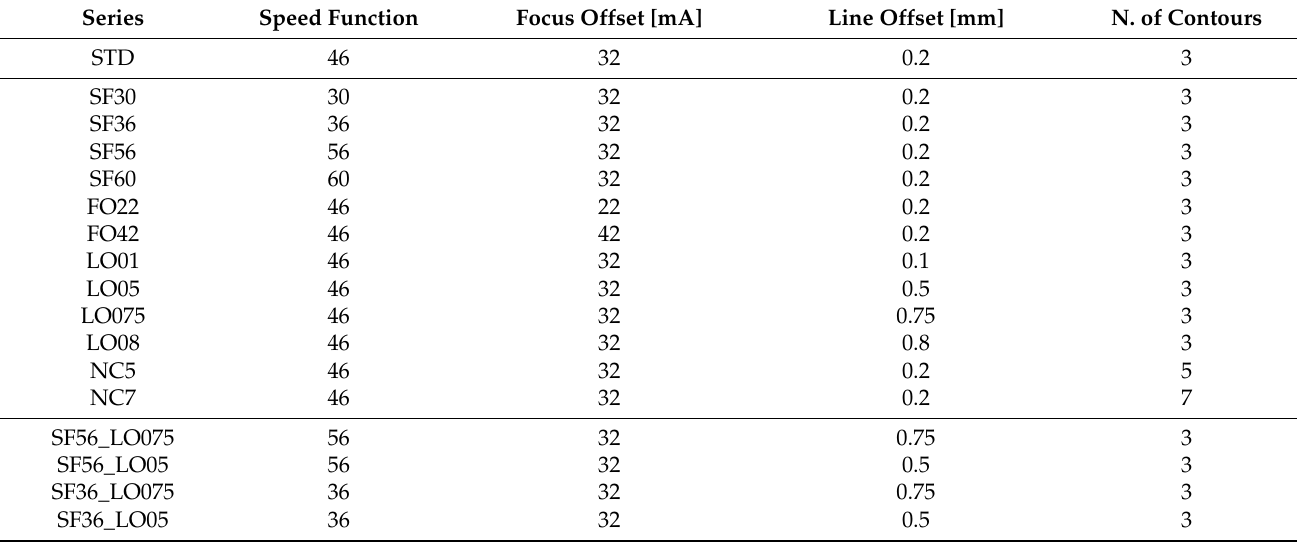
Table 2. EBM process parameters sets with the standard values in the first